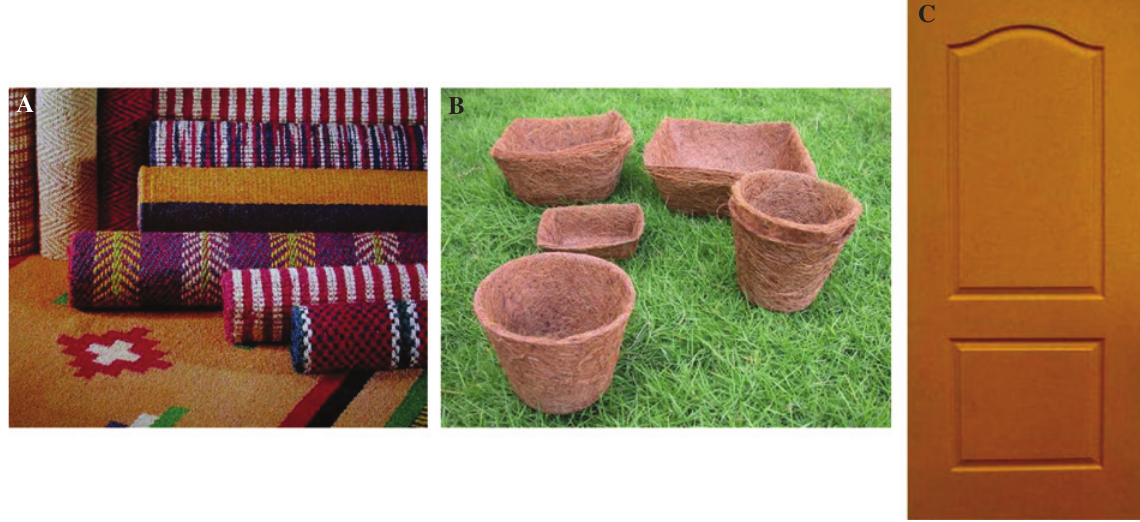
Figure 8: (A) Floor-furnishing materials, (B) gardening articles, and (C) door which are made using coir fiber.